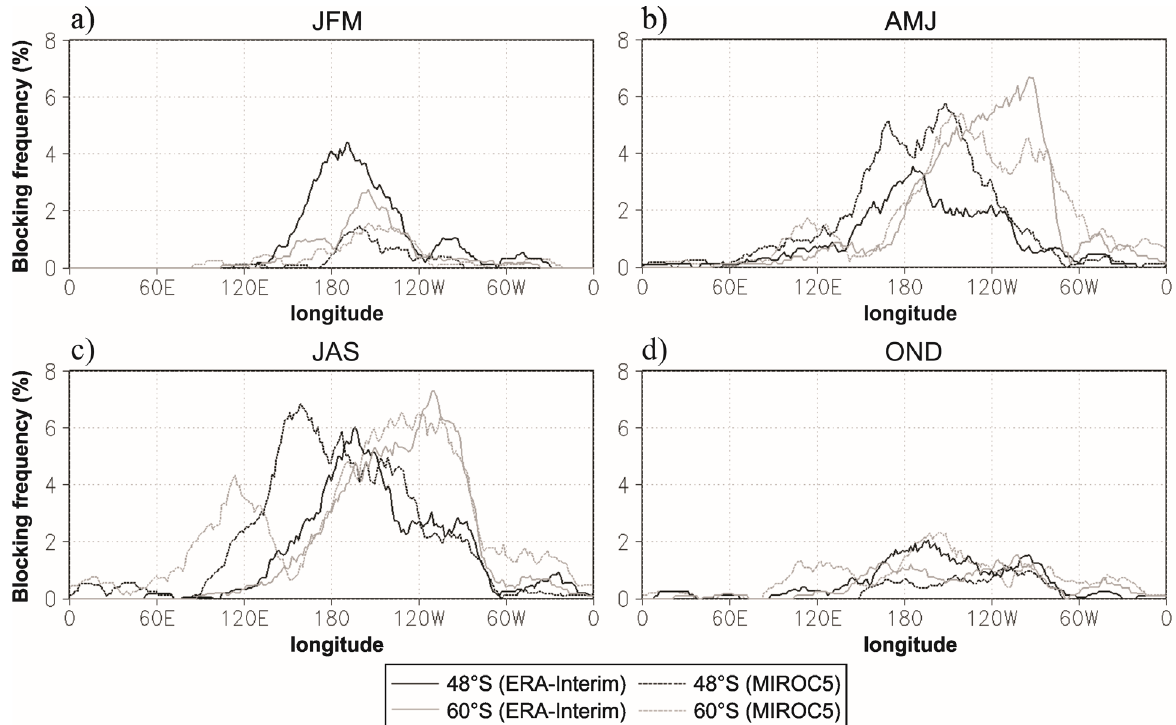
Figure 2. Seasonal frequency of blocking events by longitude (%) in the ERA-Interim reanalysis (continuous lines) and in the MIROC5 historical experiment (dashed lines) during (a) summer (JFM), (b) autumn (AMJ), (c) winter (JAS) and (d) spring (OND) over